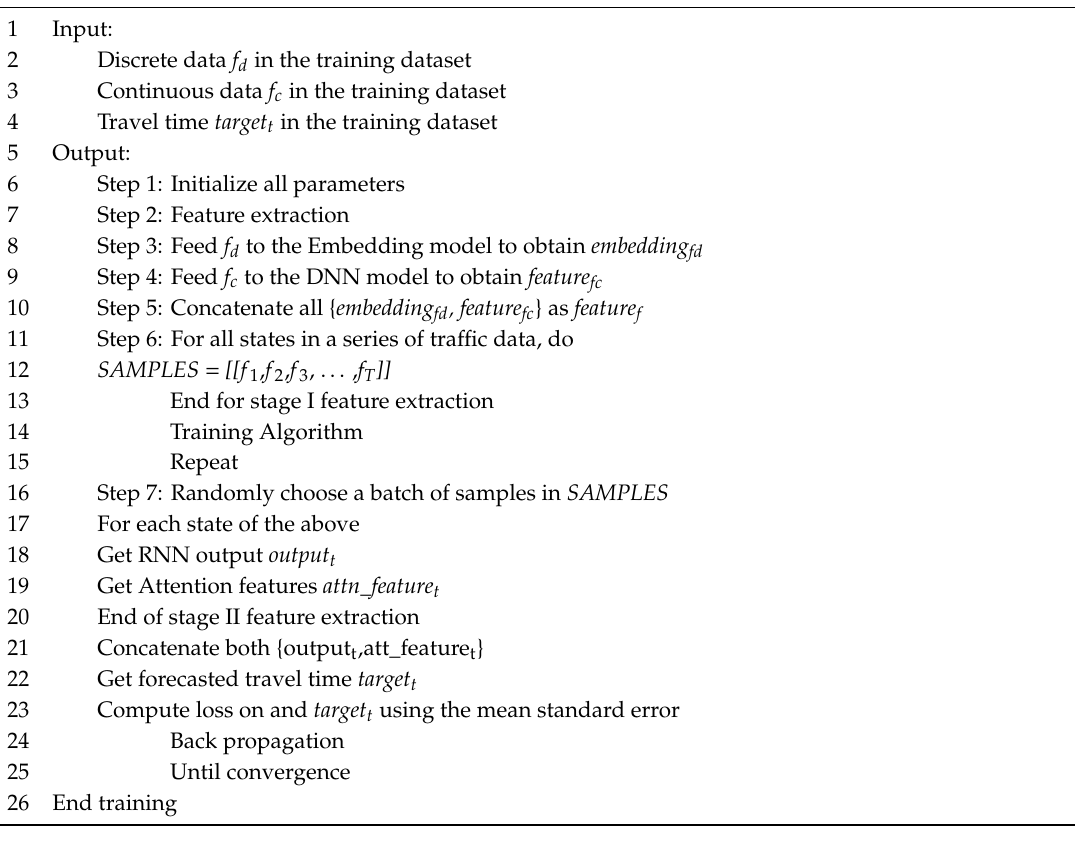
Algorithm 1: Process for Model